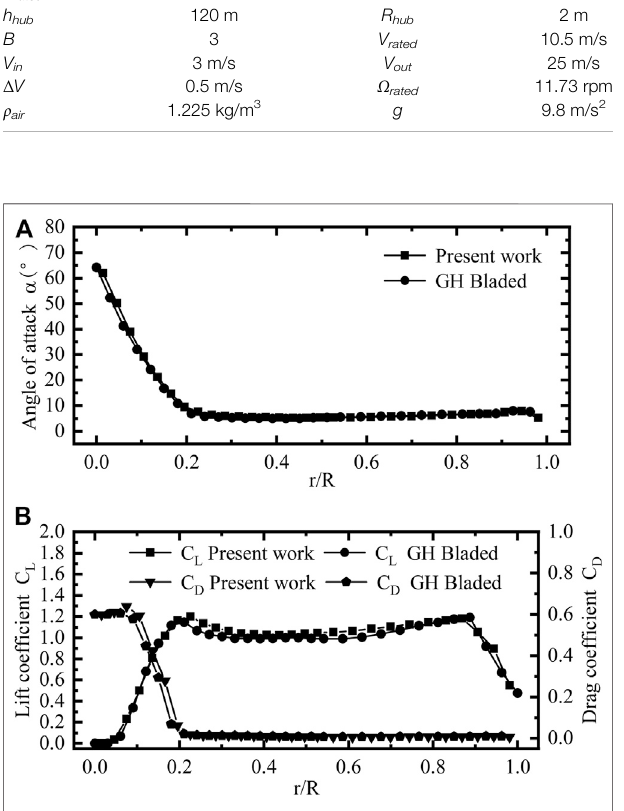
FIGURE 5 | The aerodynamic characteristics of the blades along the span under the rated wind speed. (A) Angle of attack curve. (B) Lift and drag coef fi cient curves.